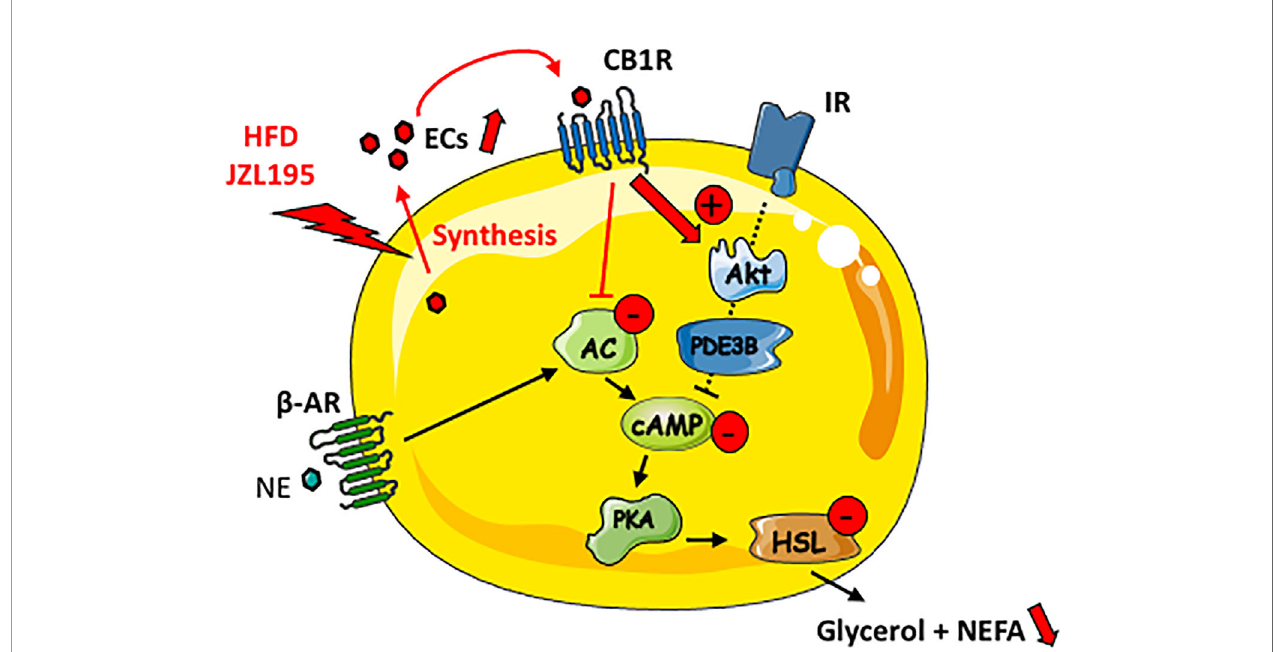
FIGURE 6 | Putative schematic representation for the cAMP-dependent lipolysis regulation by locally produced ECs in lean WAT. AC, adenylate cyclase; ß-AR, beta-adrenergic receptor; IR, insulin receptor; NE,